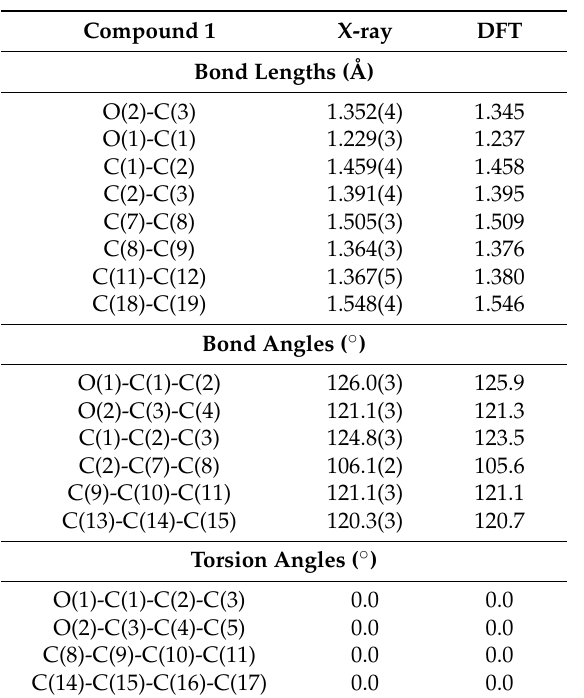
Figure 3. Displacement ellipsoid representation of 1 with the labelling scheme. The ellipsoids are drawn at the 50% probability level and the H atoms are drawn as spheres of arbitrary radii. The black dashed line denotes the intramolecular O-H ¨¨¨ O hydrogen bond. Table 2. Comparison of the experimental and optimized geometric parameters of 1 (Å and ˝ ). DFT: Density Functional